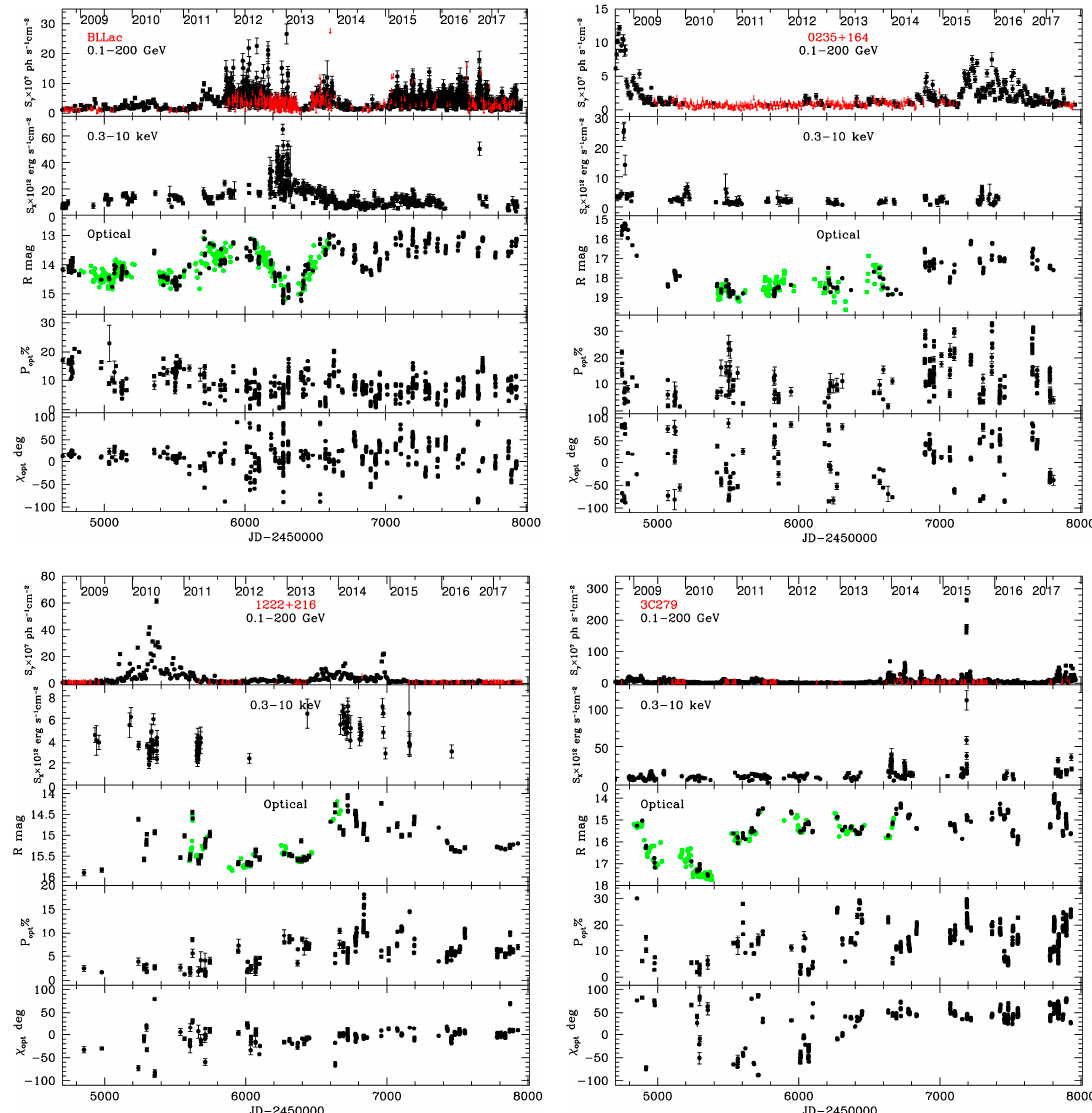
Figure 1. Top to bottom : 0.1–200 GeV γ -ray (units of 10 − 7 phot s − 1 cm − 2 ), 0.3–10 keV X-ray (10 − 12 erg s − 1 cm − 2 ), optical R-band magnitude, R-band degree (%), and R-band position angle ( ◦ ) of polarization, respectively, versus time of ( top ) two low-synchrotron-peak BL Lac objects and ( bottom ) two quasars. Green symbols of optical fluxes: measurements with the Liverpool Telescope; all other optical measurements are with the Perkins Telescope.